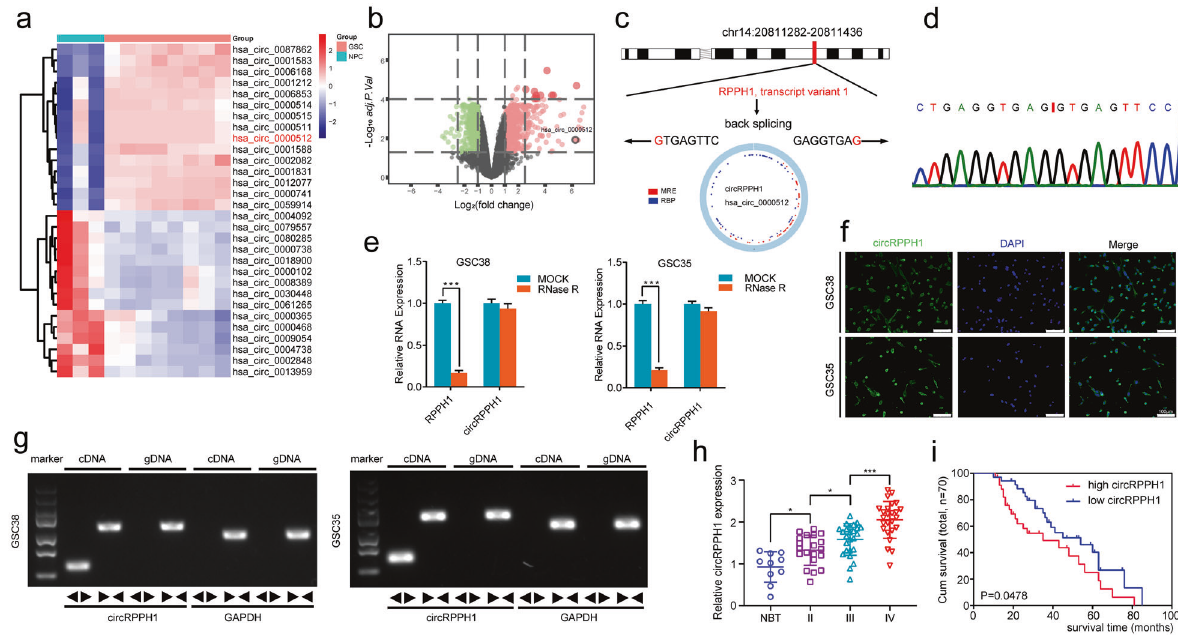
Fig. 1 CircRPPH1 is highly expressed in glioblastoma compared with normal brain tissues. a Heatmap showed that circRPPH1 was highly expressed in glioblastoma in GSE146463. b The volcano plot demonstrated that circRPPH1 was highly expressed in the glioblastoma. c The schematic illustration showed the formation of circRPPH1 via back splicing. d Sanger sequence con fi rmed the head-to-tail splicing of circRPPH1. e Relative RNA expression between RPPH1 and circRPPH1 in GSC38 and GSC35 under RNase R digesting was tested by qPCR ( p < 0.0001, Student ’ s t -test). f Fluorescence in situ hybridization (FISH) assays showed the position of circRPPH1 using a speci fi c circRPPH1 probe. Scale bar = 100 μ m. g Northern blotting showed the products of qPCR assays in cDNA and gDNA. h CircRPPH1 expressed at a higher level in WHO high grades of glioma than in normal brain tissues, tested by qPCR (grade II, n = 20; grade III, n = 25; grade IV, n = 25; NBT, n = 10, II vs. NBT. p = 0.0114; III vs. II. p = 0.0232; IV vs. III. p = 0.0002; One-Way ANOVA). i Kaplan-Meier analysis showed high circRPPH1